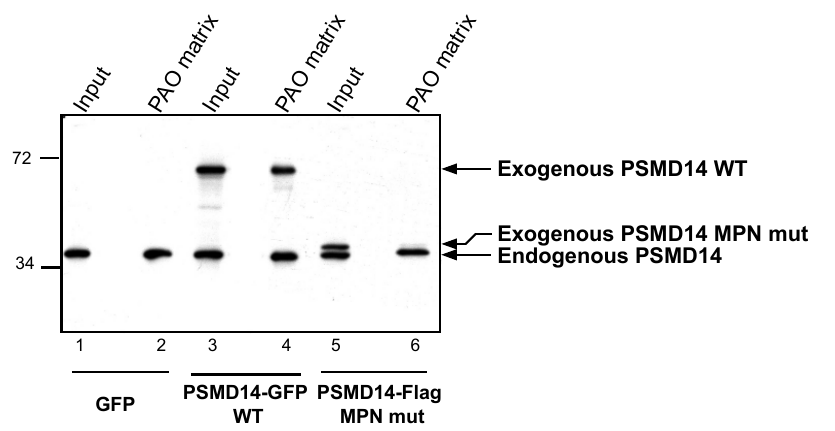
Figure 5. MPN domain mediates PSMD14 binding to PAO. PSMD14 WT or MPN mutant was evaluated towards its ability to bind a PAO matrix. Proteasomes were purified from cells expressing GFP (serving as a control), PSMD14-GFP (WT) or PSMD14-Flag (MPN mutant). Proteasomal content (input) reveals no requirement for a functional MPN domain for proteasomal binding (lanes 3 and 5). However, PSMD14 arsenite binding (PAO matrix) is detected only in the PSMD14 WT and not MPN mutant (lanes 4 vs.